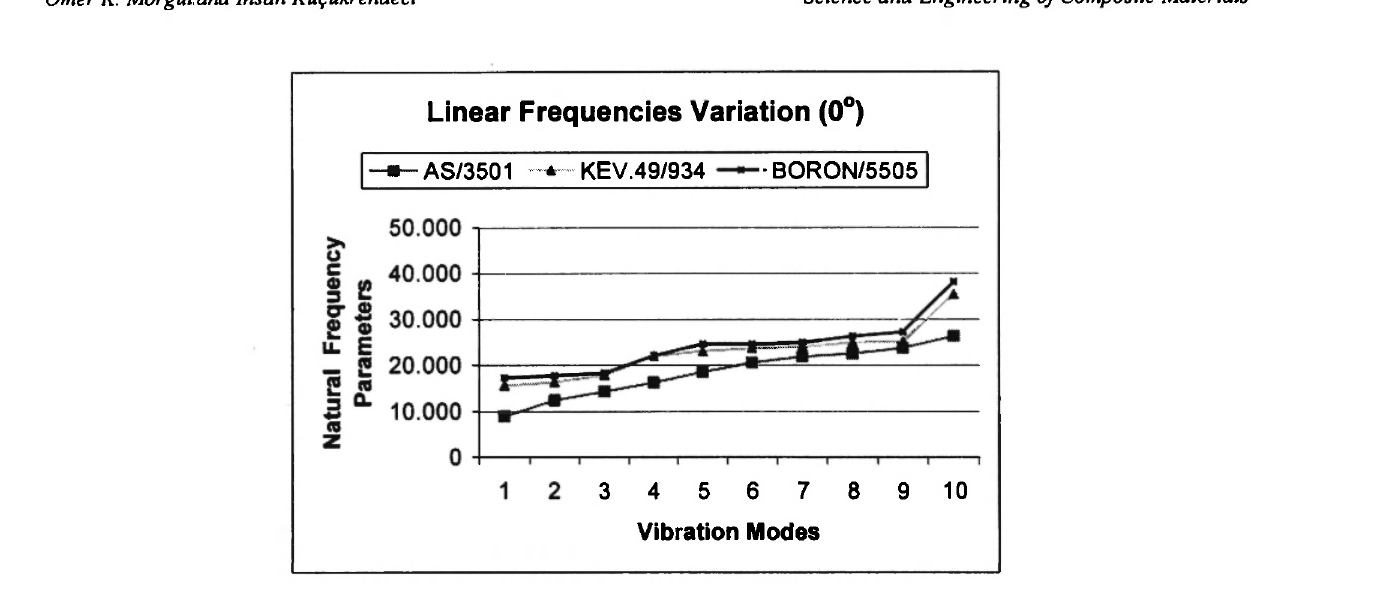
Fig. 7: AS/3501 Graphite/epoxy , Kev.49/934 Kevlar/epoxy, Boron/5505 Boron/epoxy, (θ= 0°). Linear natural frequency parameters λ of symmetrically five-layer angle-ply, square complete plates with fully clamped edges (a=0.45 m).